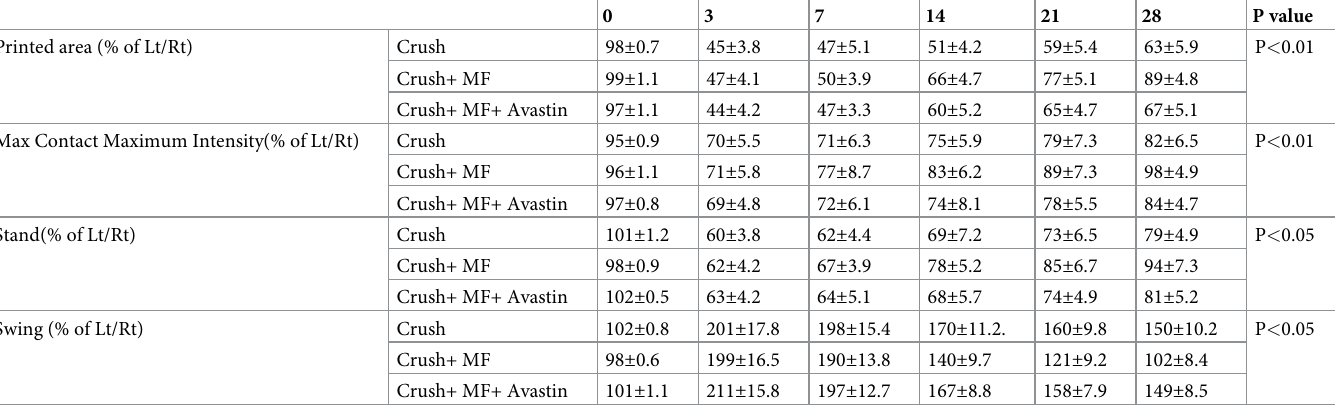
Table 2. Outcome of catwalk gait analysis in various treatment groups related to various time frames and catwalk parameters.